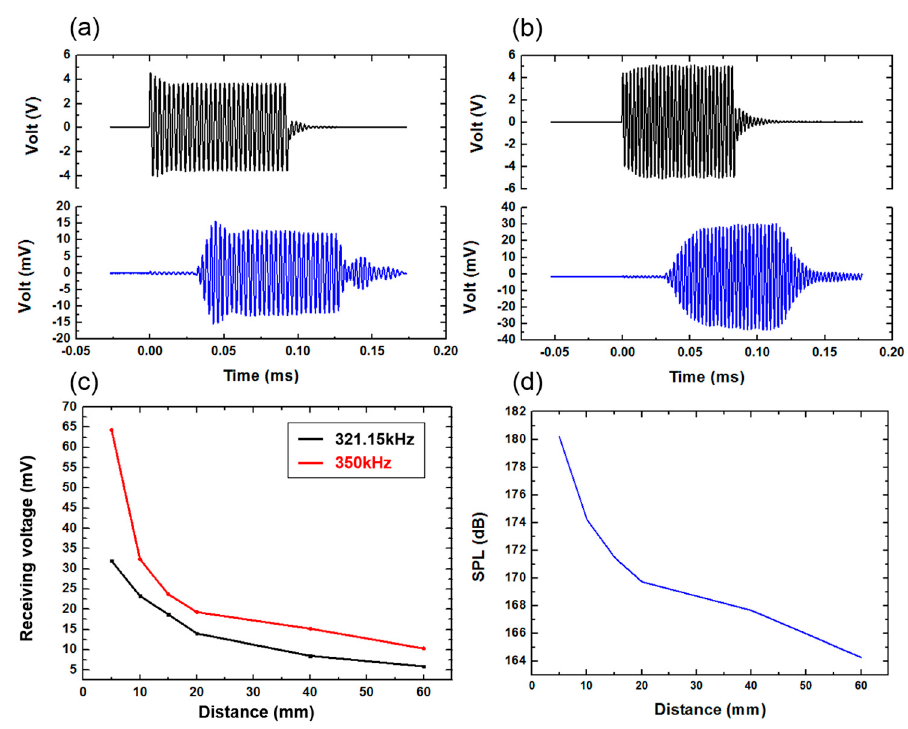
Figure 11. ( a ) The receiving signal at the frequency of 321.15 KHz. ( b ) The receiving signal at the frequency of 350 KHz. ( c ) Signal comparison at the frequency of 321.15 and 350 KHz. ( d ) The SPL tested at different distances.